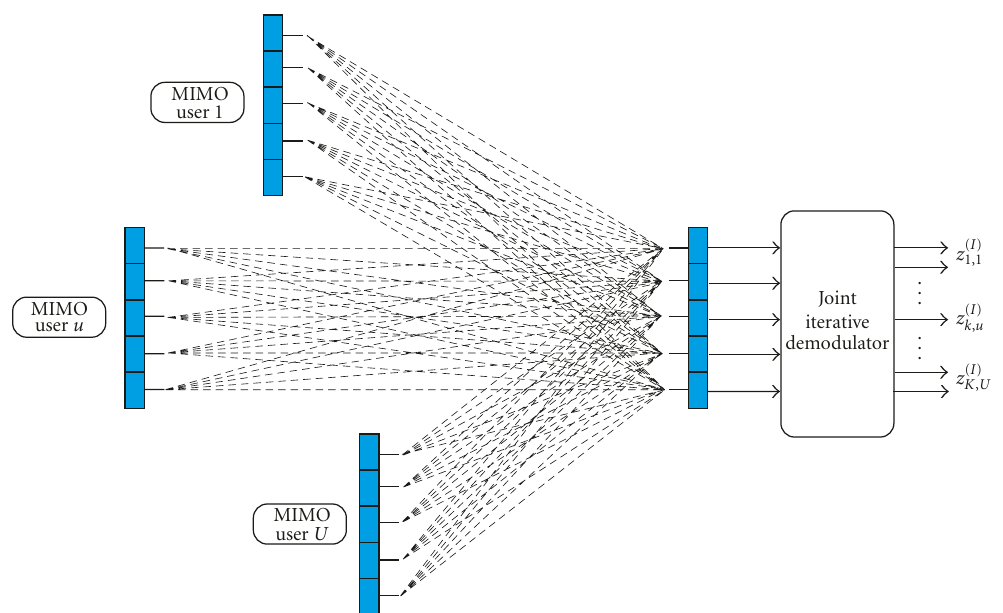
Figure 5: Structure of the proposed partitioned multiterminal MIMO transmission and